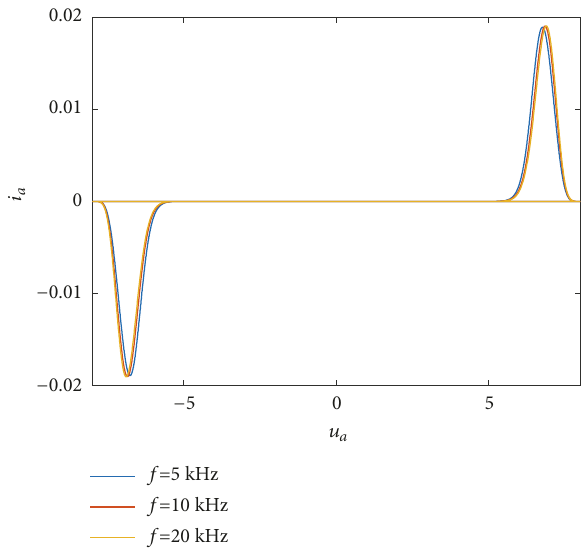
Figure 8: Loci in v - i